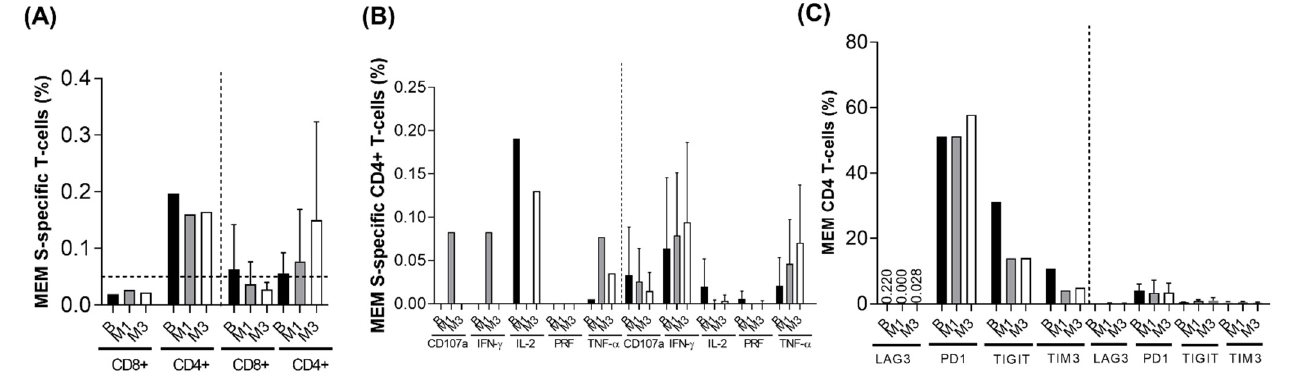
Figure 3. SARS-CoV-2 spike-specific T-cell response and exhaustion phenotype. ( A ) Spike-specific memory (MEM) CD4+ and CD8+ T-cell response, at baseline (B), month 1 (M1) and month 3 (M3), in our case (left panel) and control (right panel). ( B ) Cytokines produced by memory (MEM) CD4+ T-cell in response to SARS-CoV-2 S peptide, at baseline (B), month 1 (M1) and month 3 (M3): CD107a (degranulation marker), interferon- γ (IFN- γ ), interleukin 2 (IL-2), perforin (PRF) and tumour necrosis factor- α (TNF- α ). ( C ) Exhaustion markers from memory (MEM) CD4+ T-cells, at baseline (B), month 1 (M1) and month 3 (M3), in our case (left panel) and control (right panel): lymphocyte-activation gene 3 (LAG-3), Programmed cell death protein 1 (PD-1), T-cell immunoreceptor with Ig and ITIM (immunoreceptor tyrosine-based inhibitory motif) domains (TIGIT), T-cell immunoglobulin and mucin domain-containing protein 3 (TIM-3).